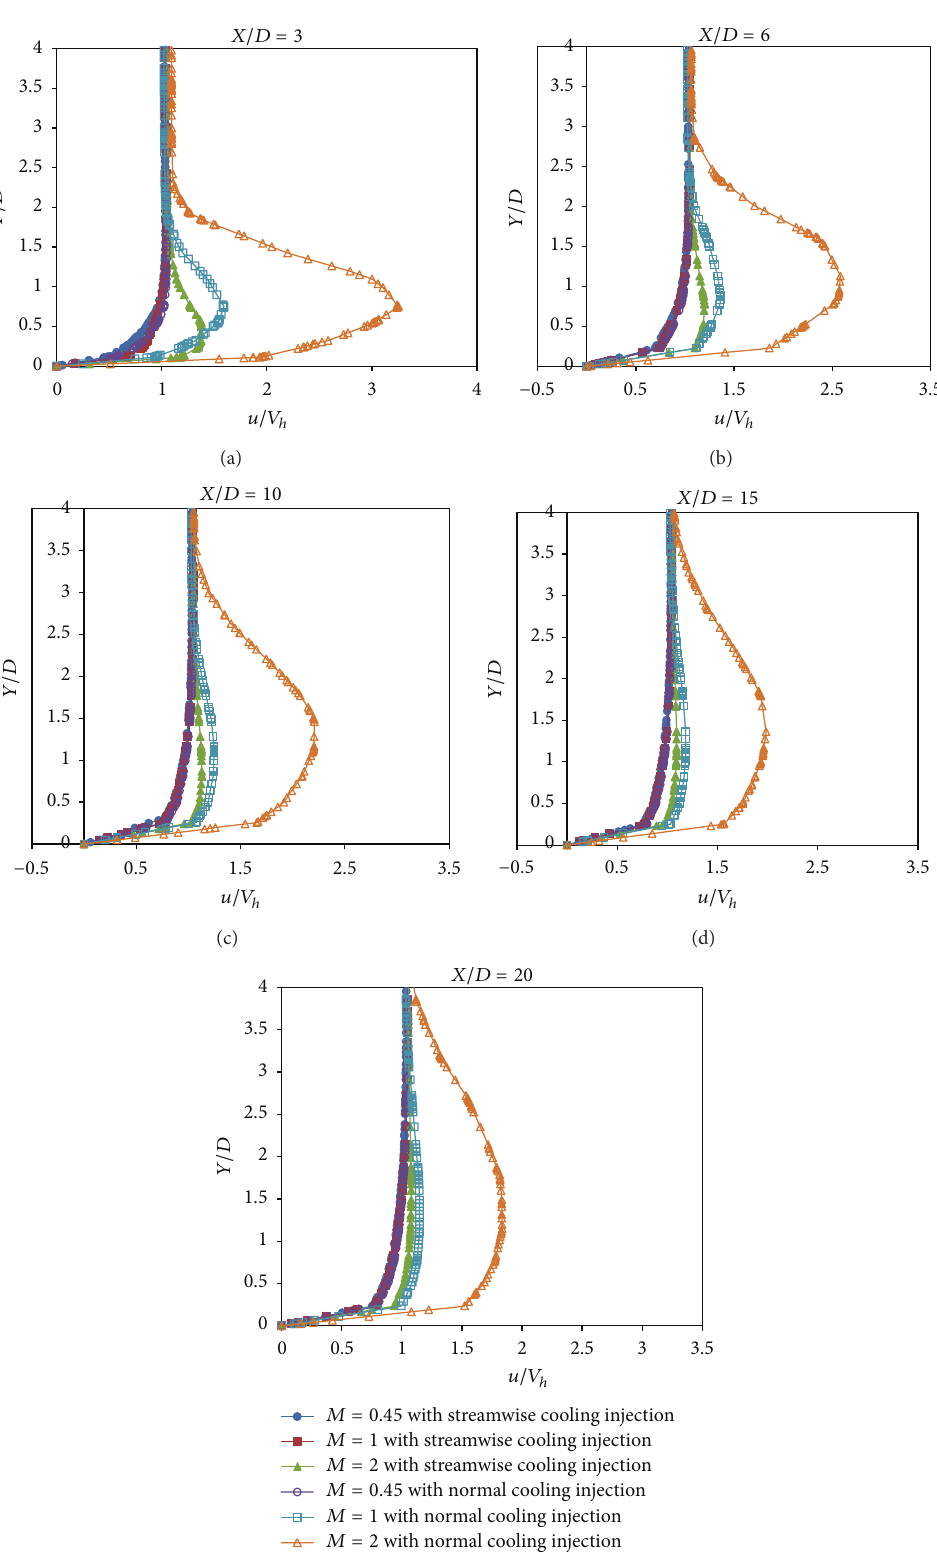
Figure 21: Velocity profile at the wall centerline for LFDSA-15-15 and different blowing